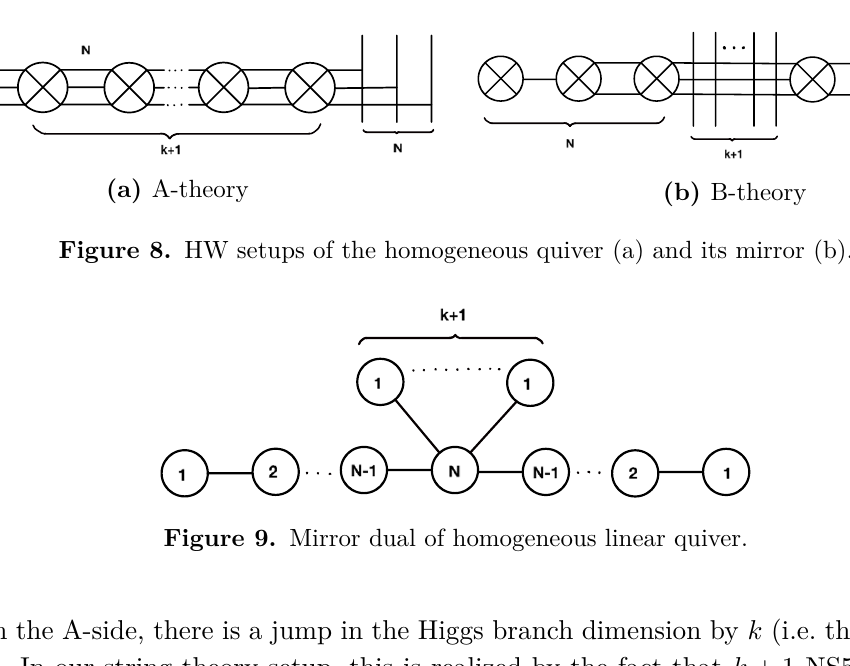
Figure 7. Homogeneous linear quiver.